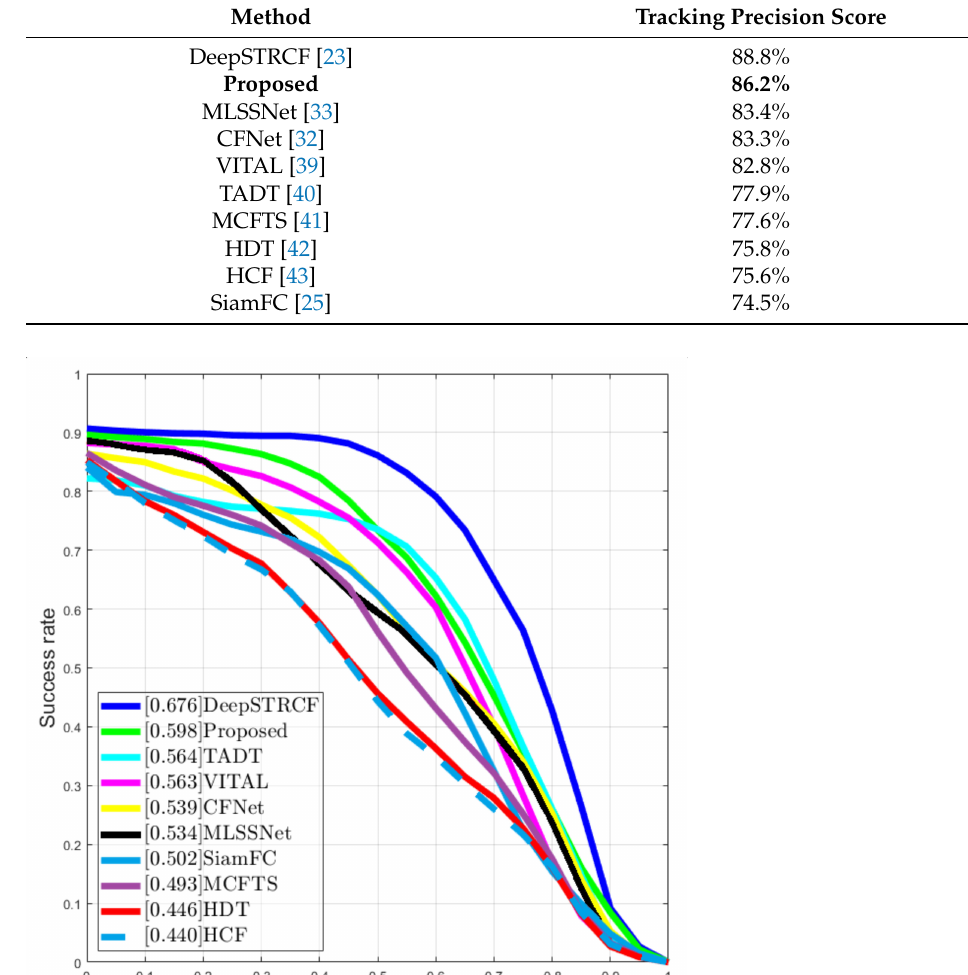
Table 3. Evaluation with respect to the precision metric.